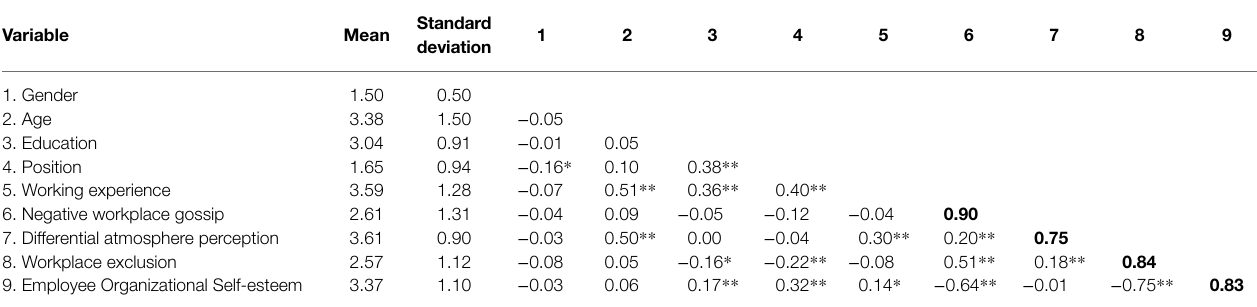
TABLE 3 | Descriptive statistics and related analysis results ( N = 228).